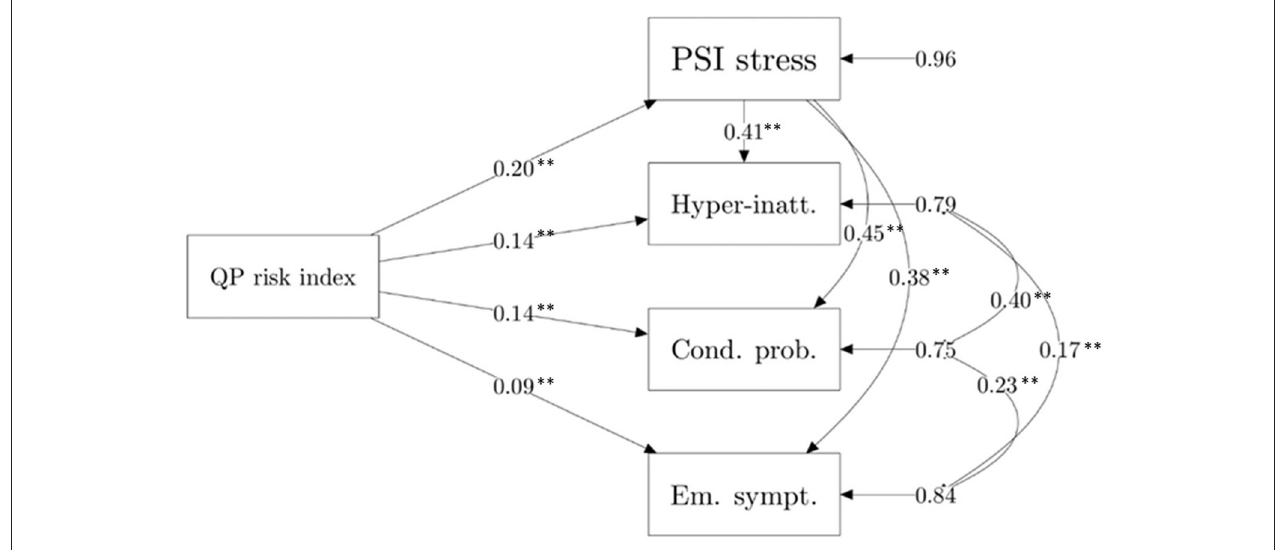
FIGURE 1 | Multivariate mediation model, including dyadic parenting stress (PSI stress) as a mediator. QP risk index, Quarantine parent risk index. ** p < 0.01.